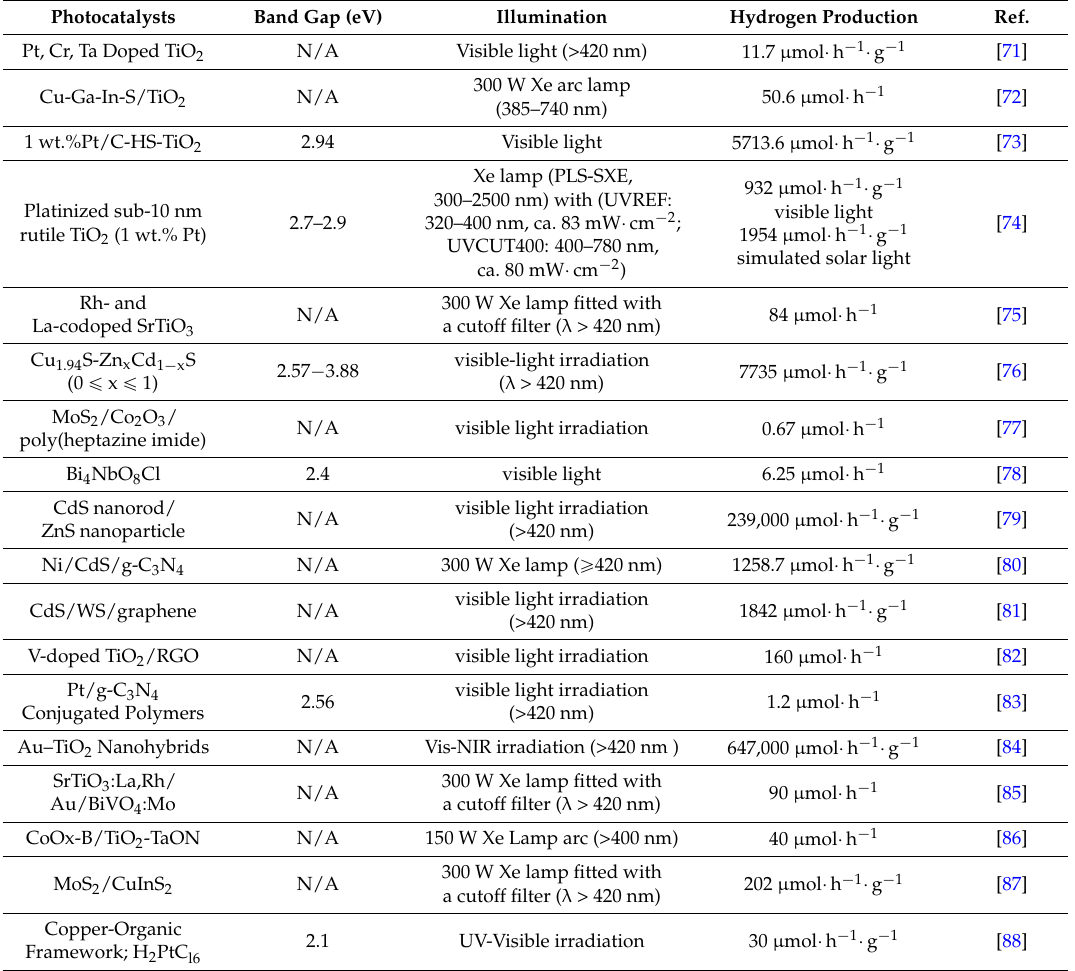
Table 1. Recent visible light active photocatalysts for water